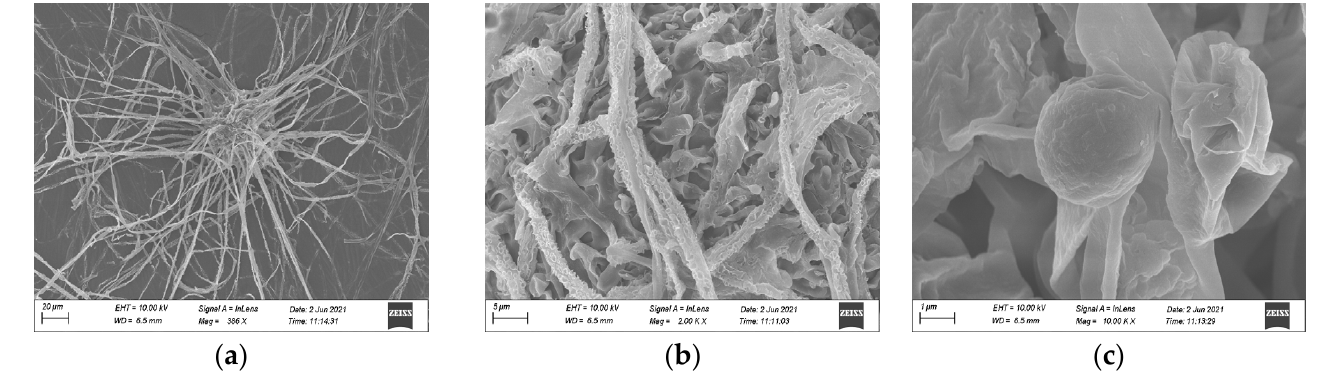
Figure 3. The reproductive structures of MR ‐ 57 isolate: ( a ) ascomata, ( b , c ) ascospores.